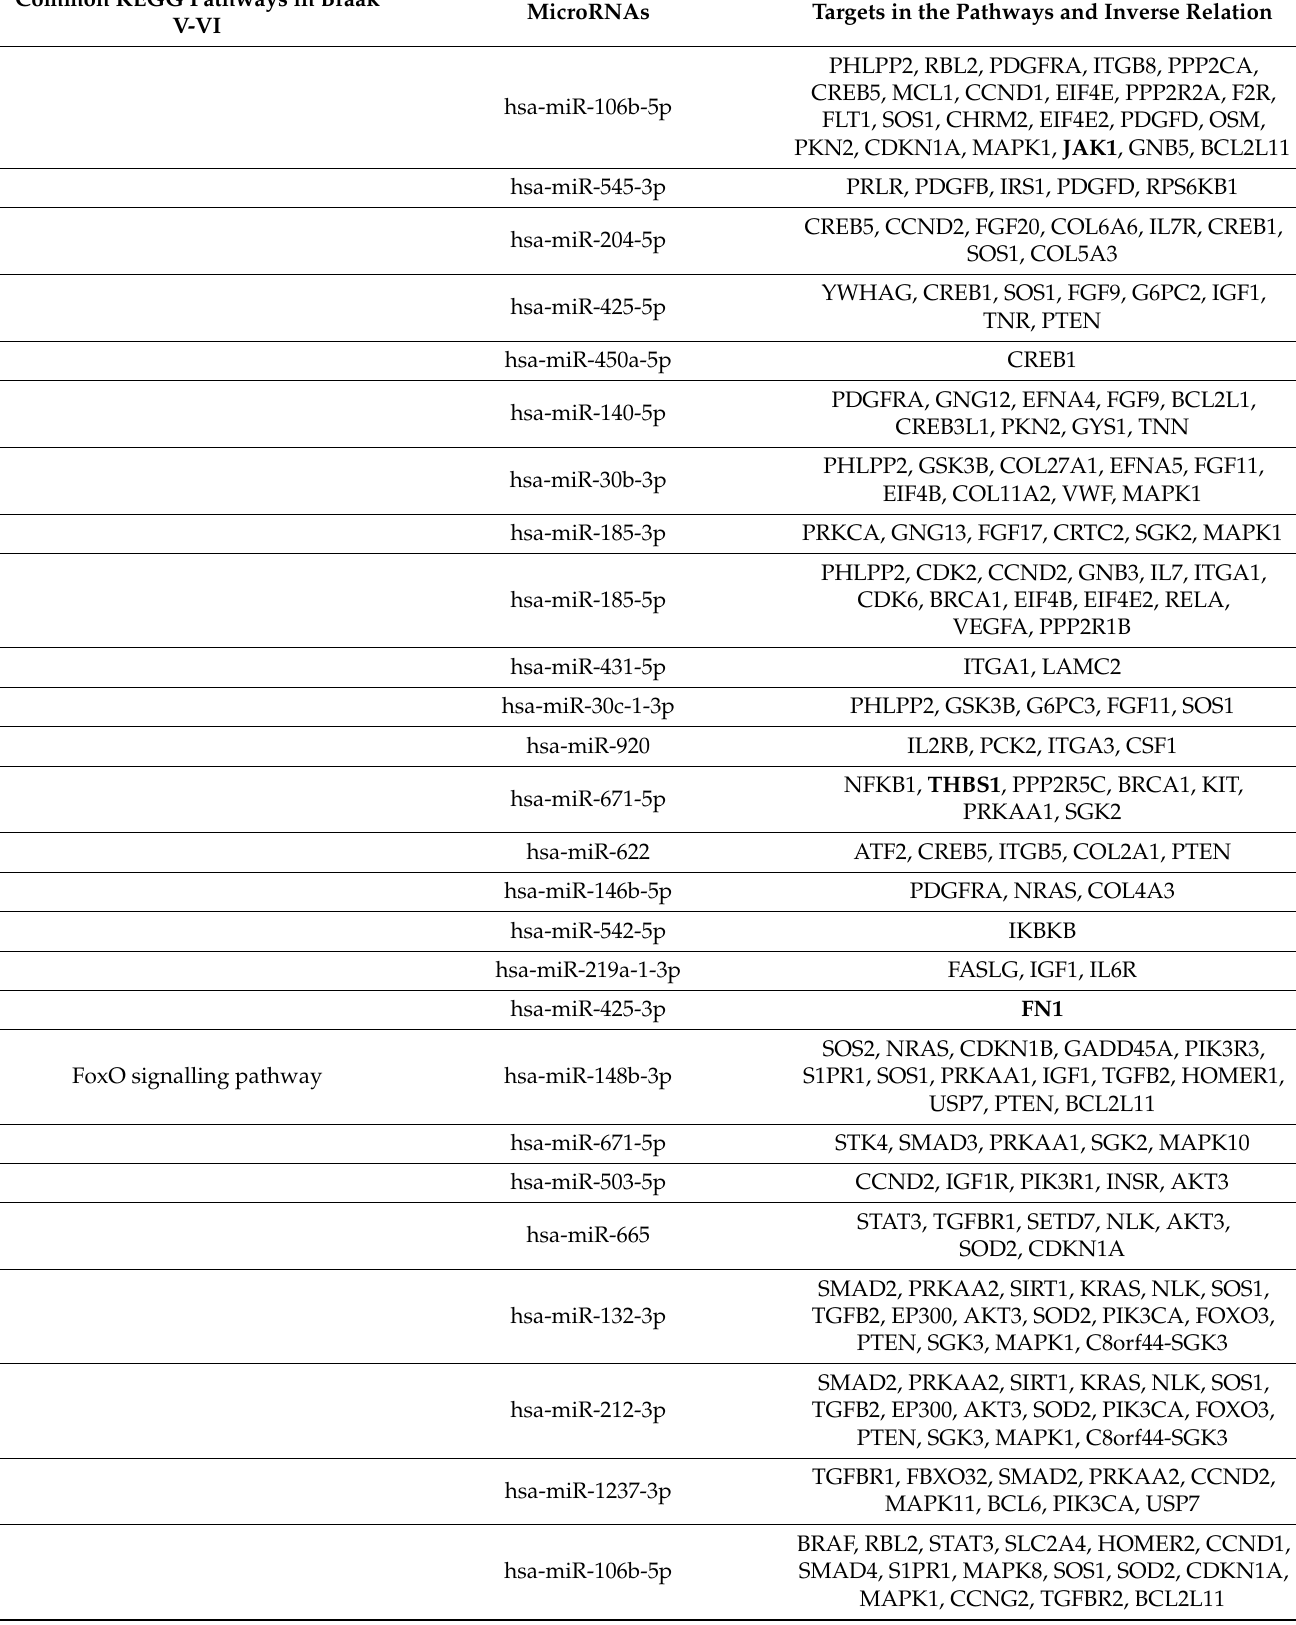
Common KEGG Pathways in